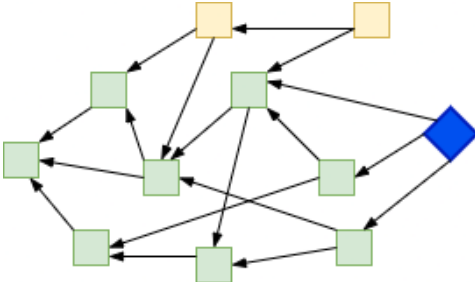
Figure 10. Transactions unreachable from